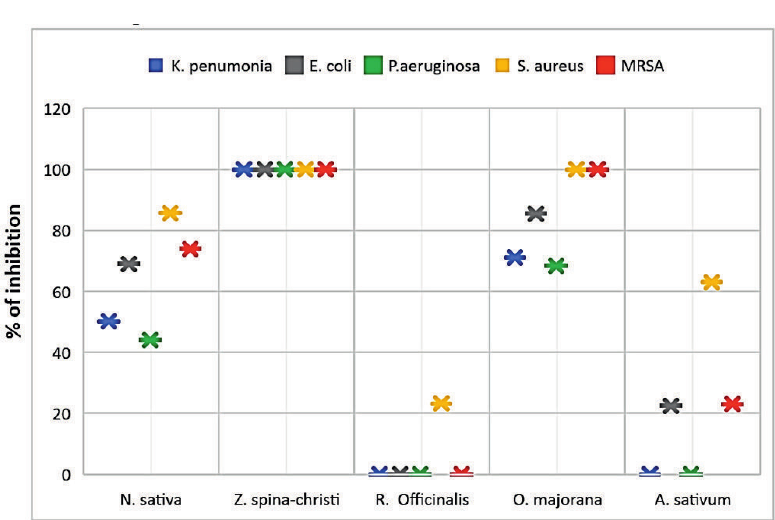
Fig. 2. Antibacterial activities of used plant extracts against tested MDR-bacteria the antibacterial activity of polyphenols fraction of and minimum bactericidal concentration were Z. spina-christi was stronger than the activity of its determined for both the Z. spina-christi total total extract (Fig. 4). These results indicated that extract and its polyphenol fraction. the antibacterial activity of Z. spina-christi might be attributed to its phenolic compounds. Although The obtained results showed that MICs the basic-alkaloids fraction showed antibacterial activity, it was much less than the polyphenols fraction effect where showed moderate influence against tested organisms with inhibition zones diameter 8.31±1.3-12.0±1.1 mm and 45.61 ± 0.39- 71.88±0.60 % of mean cells growth inhibition (Table 2 & Fig. 3). The impregnated discs and mean growth inhibition percentages showed no inhibitory effect in the presence of acidic-alkaloids fraction against all tested bacterial isolates (Table 2 & Fig. 3).